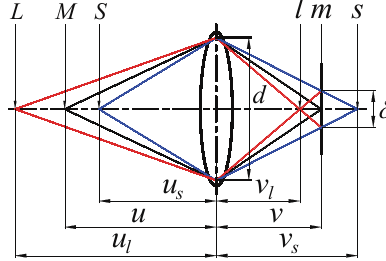
Figure 5. Diagram for calculating the depth of field